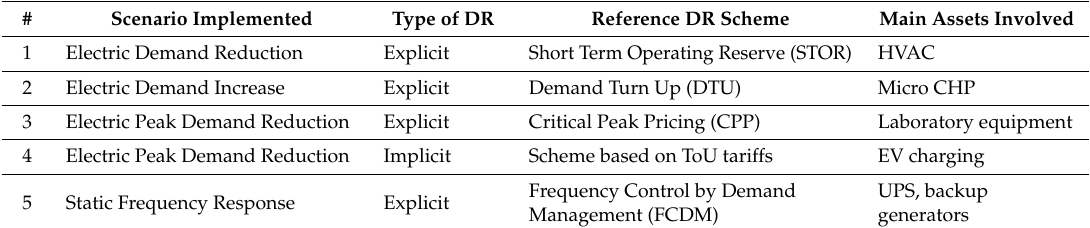
Table 1. Demand Response (DR) scenarios and scheme implemented in the UK pilot site.